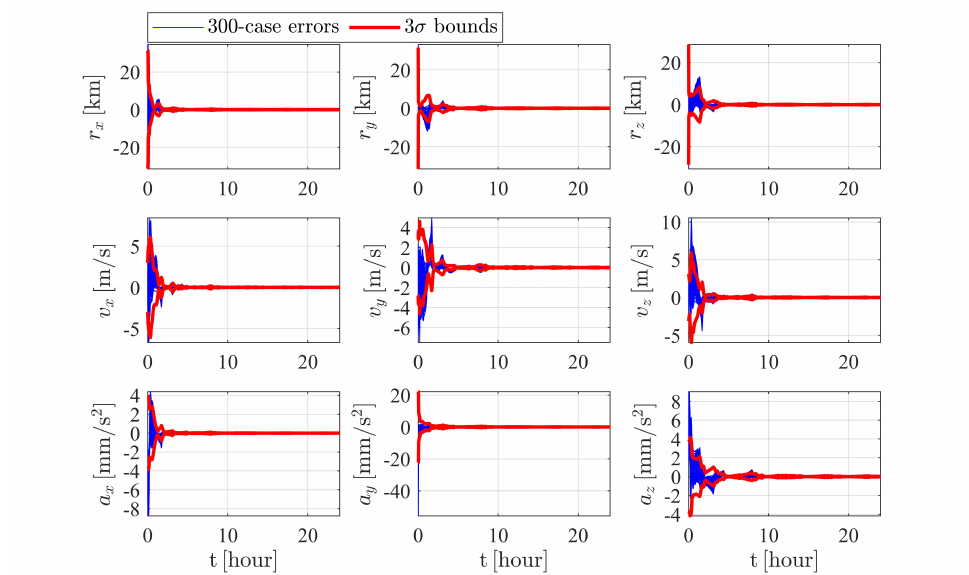
Figure 15. Monte Carlo simulations results of the non-maneuvering